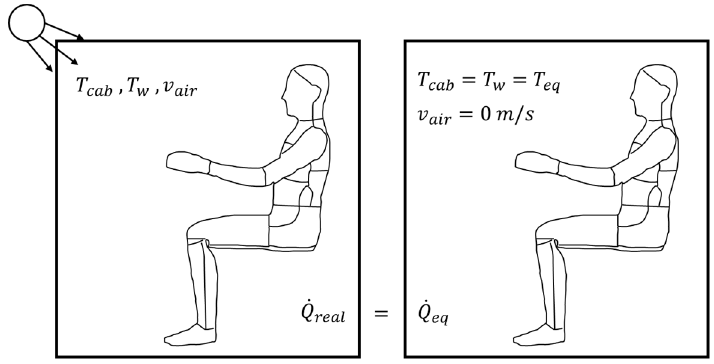
Figure 6. Definition of the equivalent temperature: real and imaginary environments.